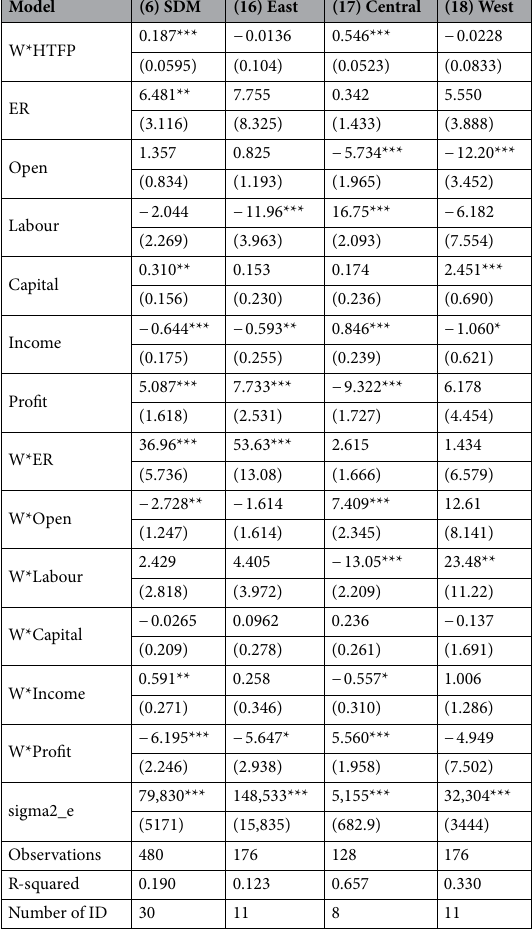
Table 9. Result of heterogeneous regression. *, **, ***indicate significance at the 10%, 5% and 1% level, and the standard errors are in